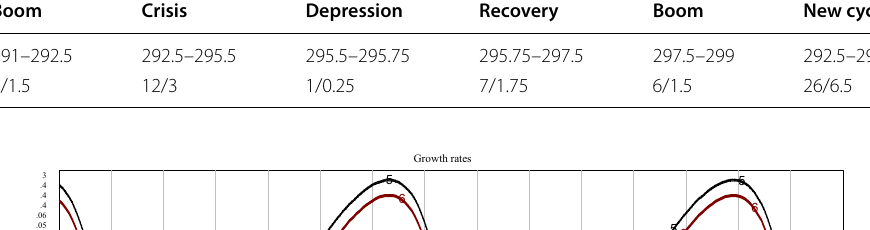
Table 15 Duration of phases of the two adjacent industrial cycles (quarters/ years) in L-2 Boom Crisis Depression Recovery Boom New cycle 291–292.5